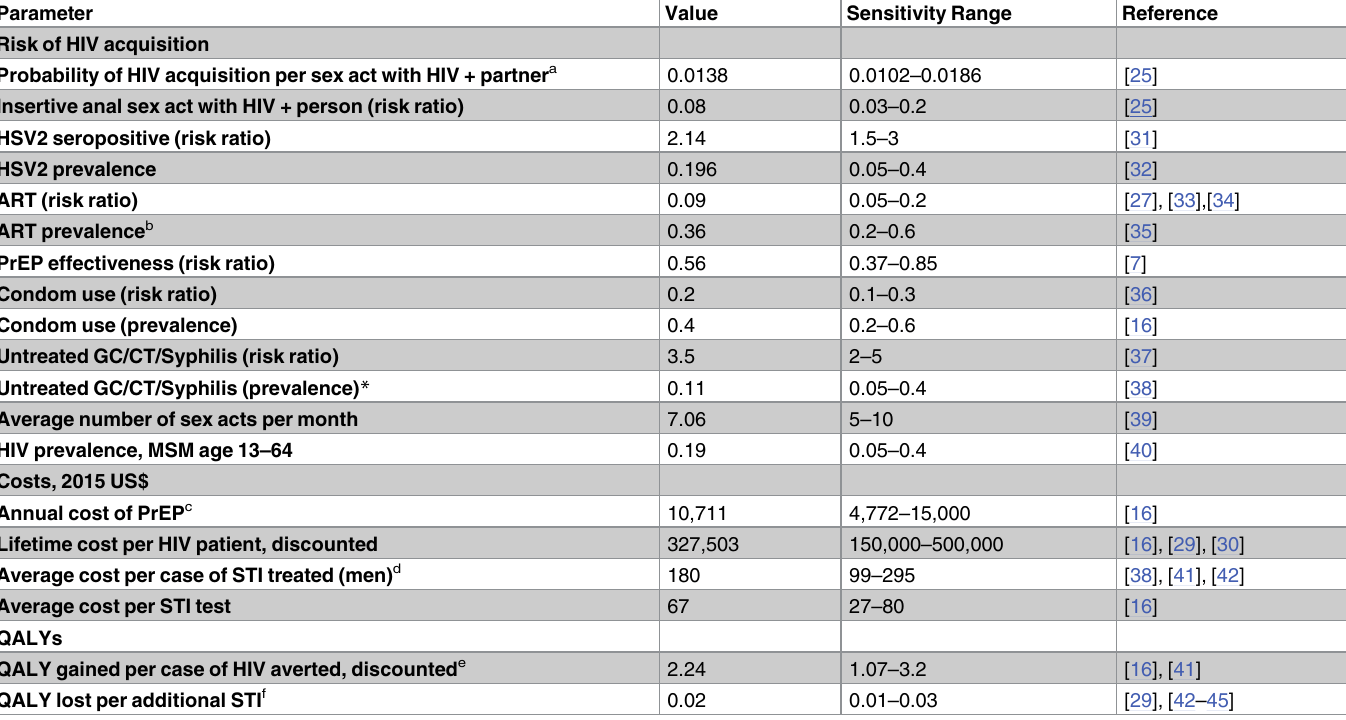
Table 1. Parametervalues for